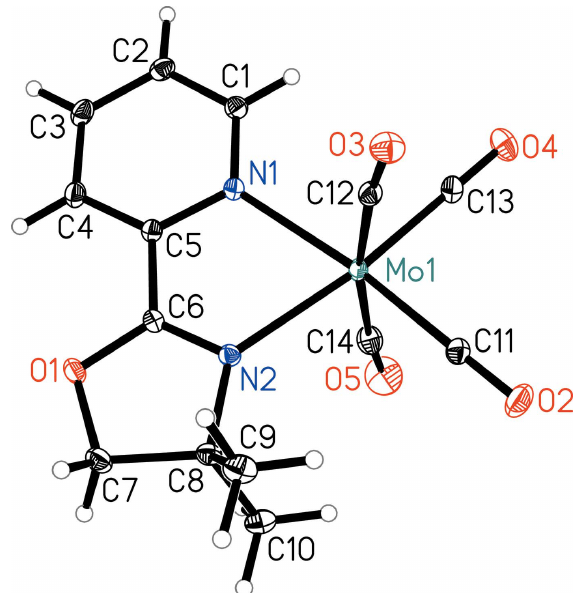
Figure 1 Molecular structure of the title compound showing the atom-labelling scheme. Displacement ellipsoids correspond to 30% probability.